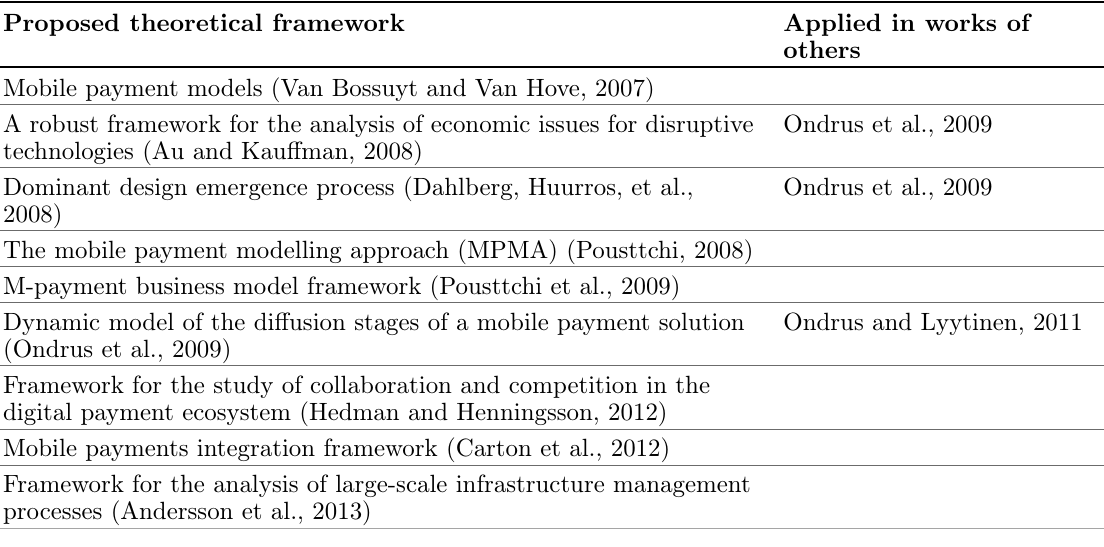
Table 18. Theoretical frameworks proposed by researchers studying mobile payments. Proposed theoretical